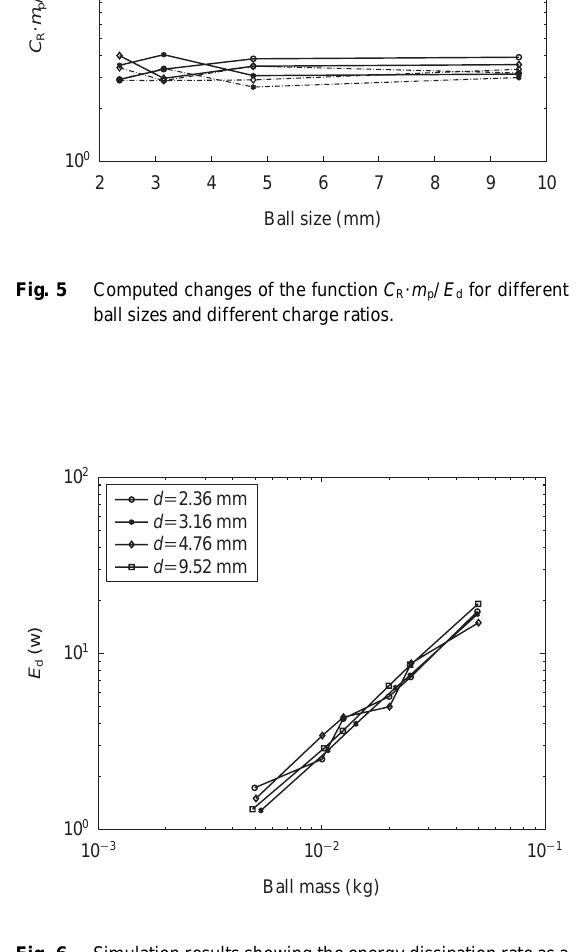
Simulation results showing the energy dissipation rate as a function of the ball mass for different ball